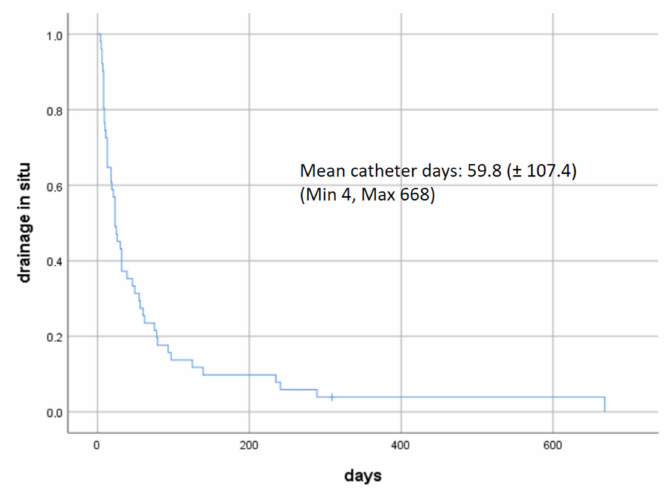
Figure 2. Kaplan–Meier curve ( n = 51). Time from PleurX insertion to loss of drainage (death ( n = 46)